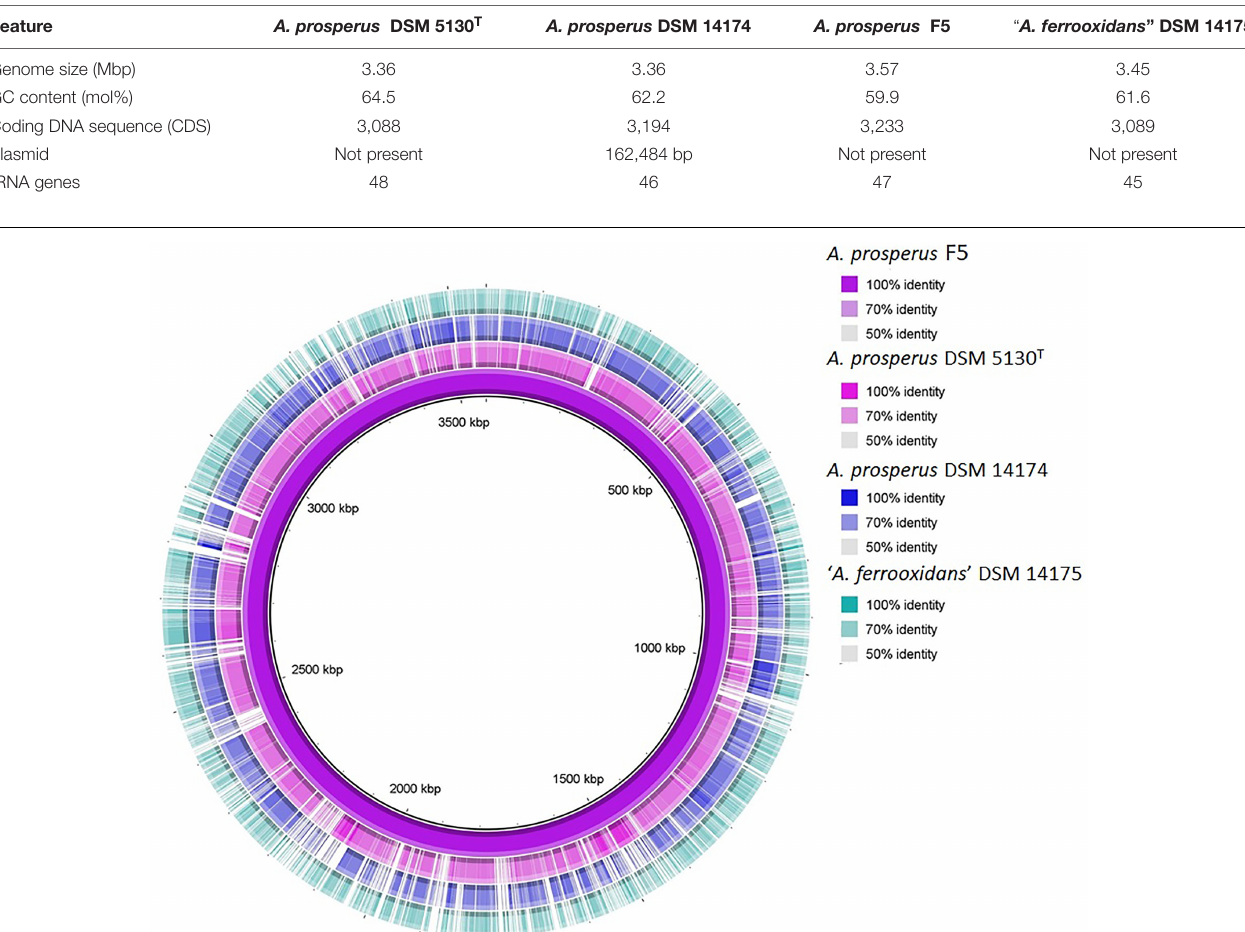
Table 2 . Differences in the presence of genes for halotolerance between the species/strains are shown in Figure 2 . Halotolerance mechanisms shared by the members of the Acidihalobacter genus are shown in Figure 3